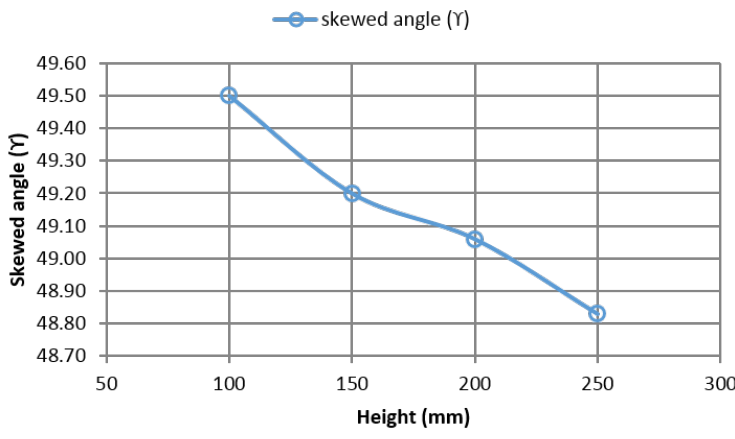
Figure 16. Skewed angle for CAWT for Y = 100 mm, 150 mm, 200 mm, and 250 mm.